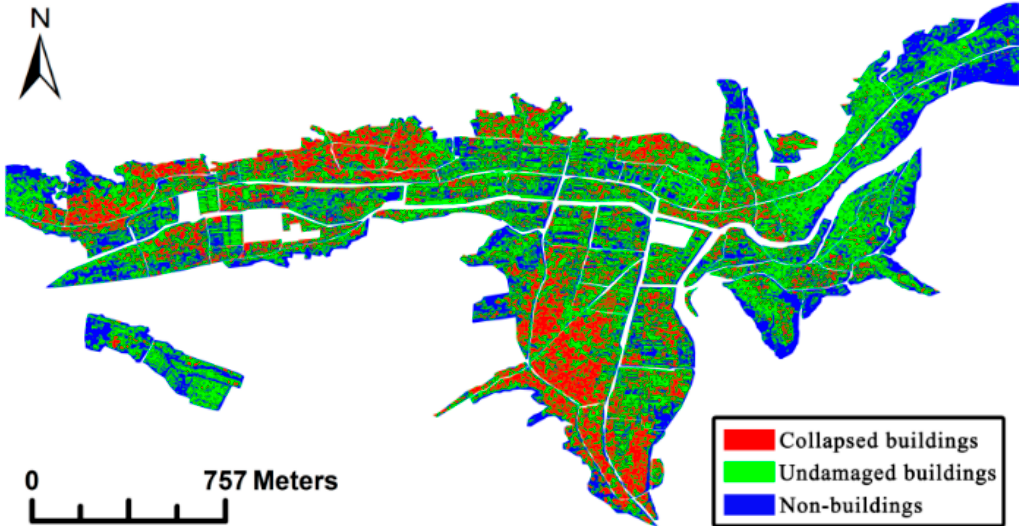
Figure 15. Extraction results of CB, undamaged buildings (UDB), and nonbuildings (NB) in the earthquake-hit urban area of Yushu County.